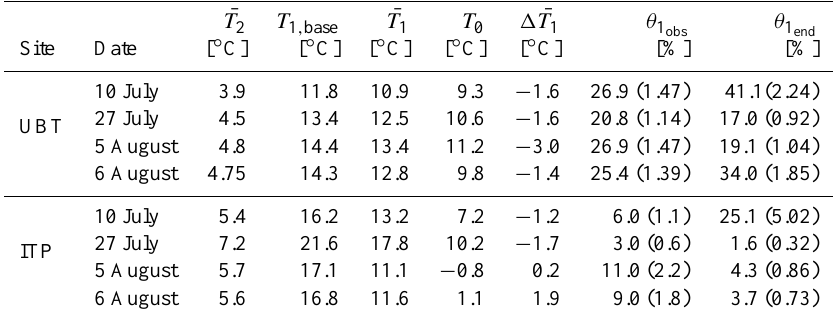
Table 2. Initial soil temperatures used in this study ( ¯ T 2 and ¯ T 1 are estimated from the respective base and top temperatures of the layer according to a quadratic temperature profile), change of layer 1 mean temperature ( 1 ¯ T 1 ) over the modified Hybrid run, soil moisture content of layer 1 at beginning of the modified model run ( θ 1 ) and at the end of the simulation ( θ 1 ). The values in parenthesis are expressed as obs end θ 1 / F C